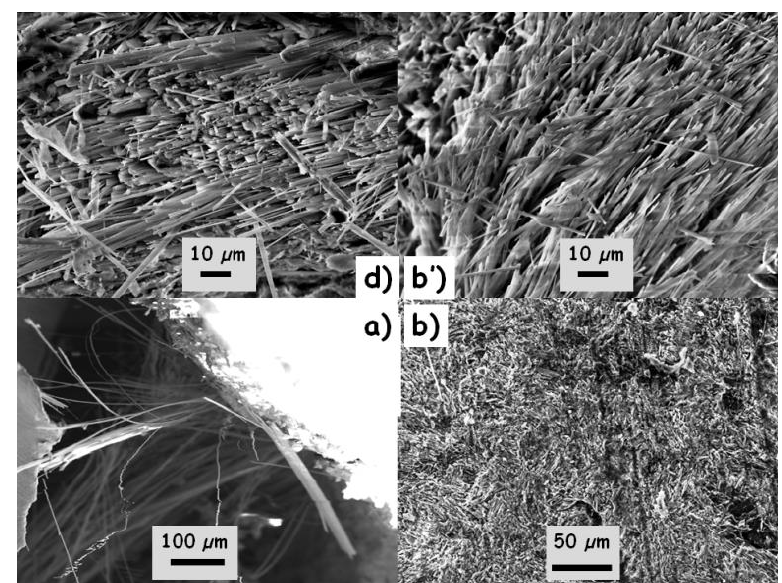
Figure 2. SEM micrographs showing asbestos fiber clusters in broken sections of samples ( a , b , d ) (see Figure 1); ( a ) large fiber pull-out after fracture; ( b’ ) detail of the sliced section of sample ( b ) showing the fiber bundles.